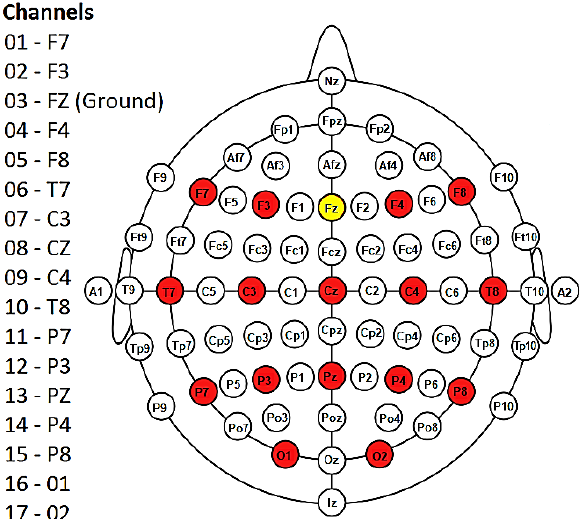
Figure 5. Diagram showing the 16 electrodes (in red) placed according to the 10 – 20 international system. Fz (in yellow) represents the ground. Note that the NeXus-32 headset does not use an electrode as a reference; rather, a hardware common average reference is used. Figure modified from [50].